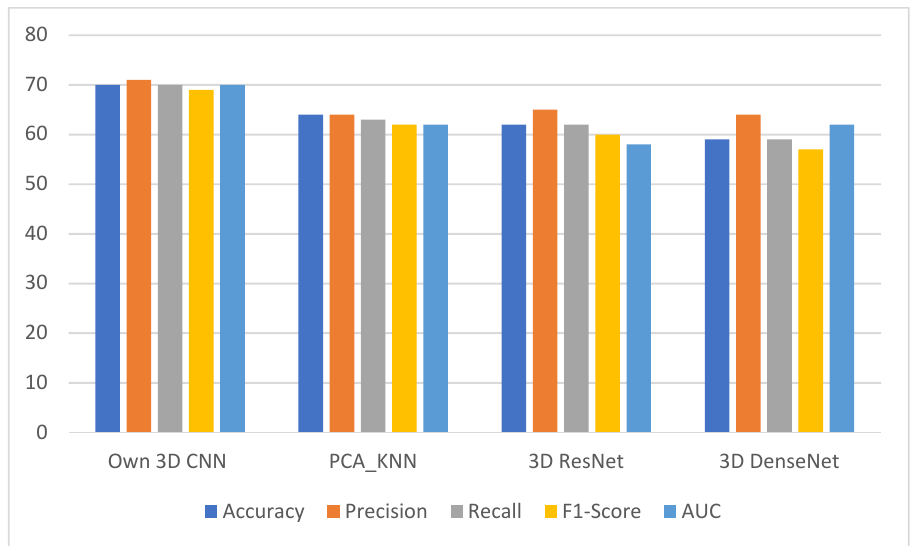
Figure 9. The grouped bar chart shows that our own 3D CNN has the highest performance among all prediction models. all prediction